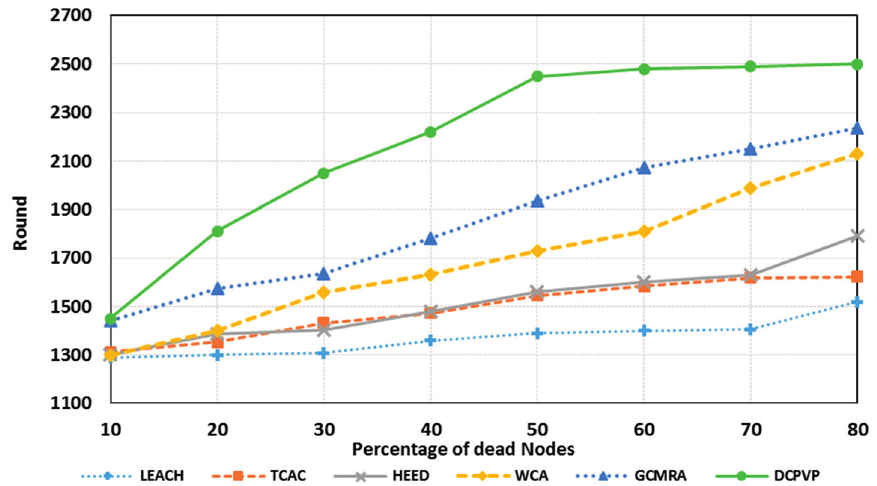
Figure 11. The percentage of dead nodes in uniform distribution for 144 nodes.